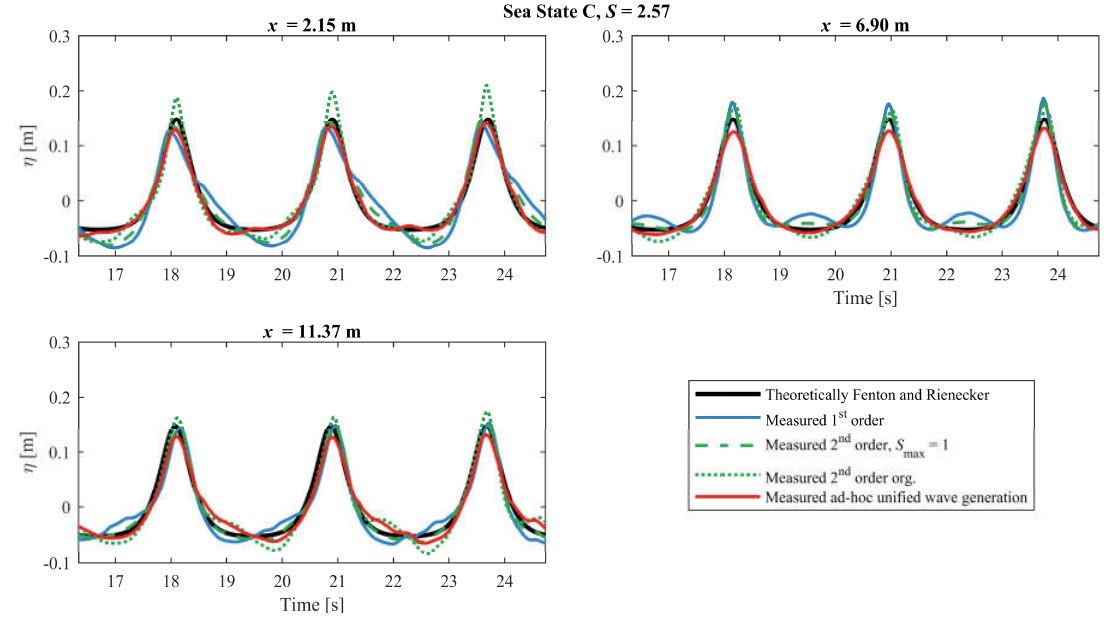
Figure 7. Theoretically surface elevation compared with the first-order, second-order, modified second-order and the ad-hoc unified wavemaker methods for Sea State C.